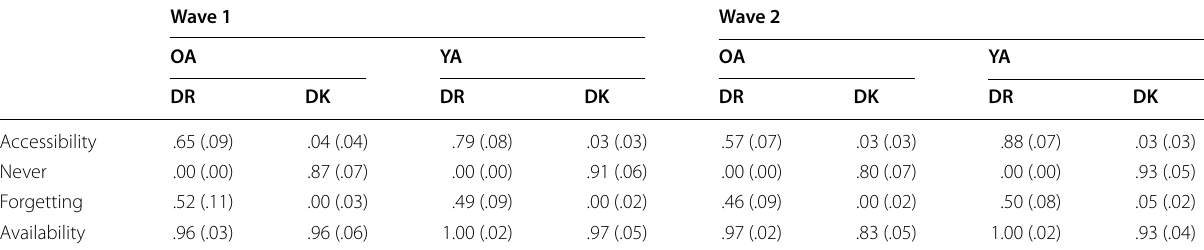
Table 3 Proportion of participants’ responses referencing dimensions as a function of question, age, study, and dimension in Waves 1 and 2 (standard error of the mean in